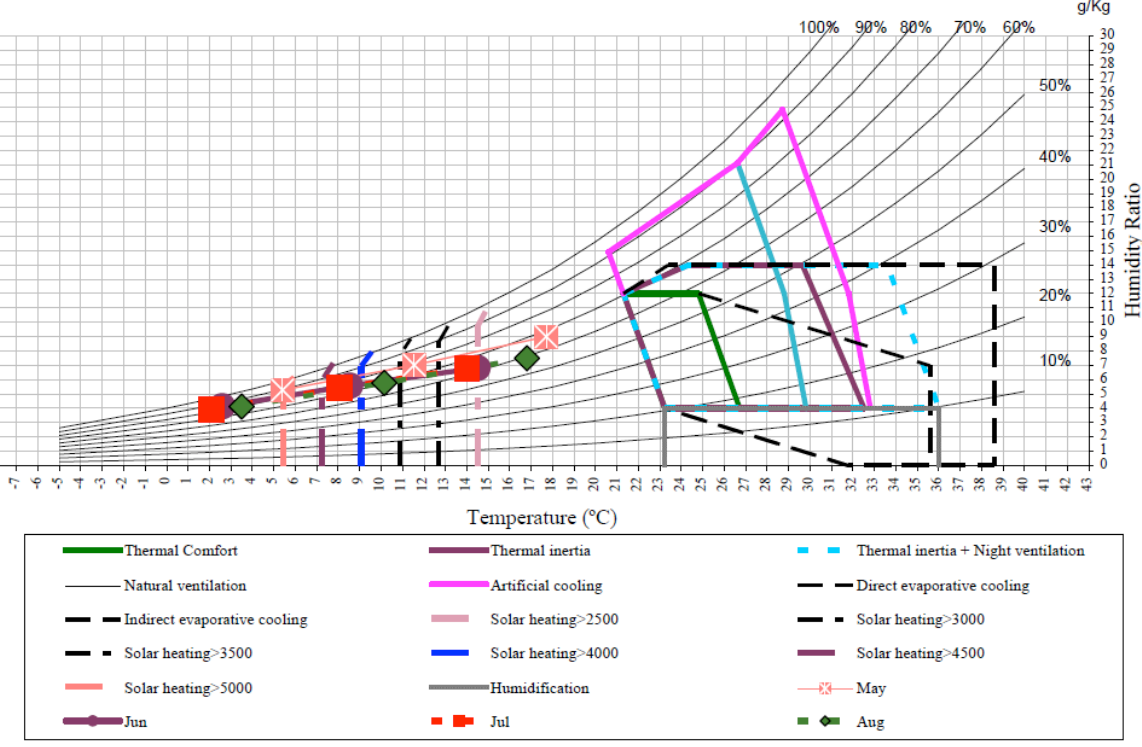
Figure 2. Winter psychrometric chart. The average minimum temperature values during June, July and August indicate that mechanical auxiliary heating is required. The solar resource is not enough for these values.